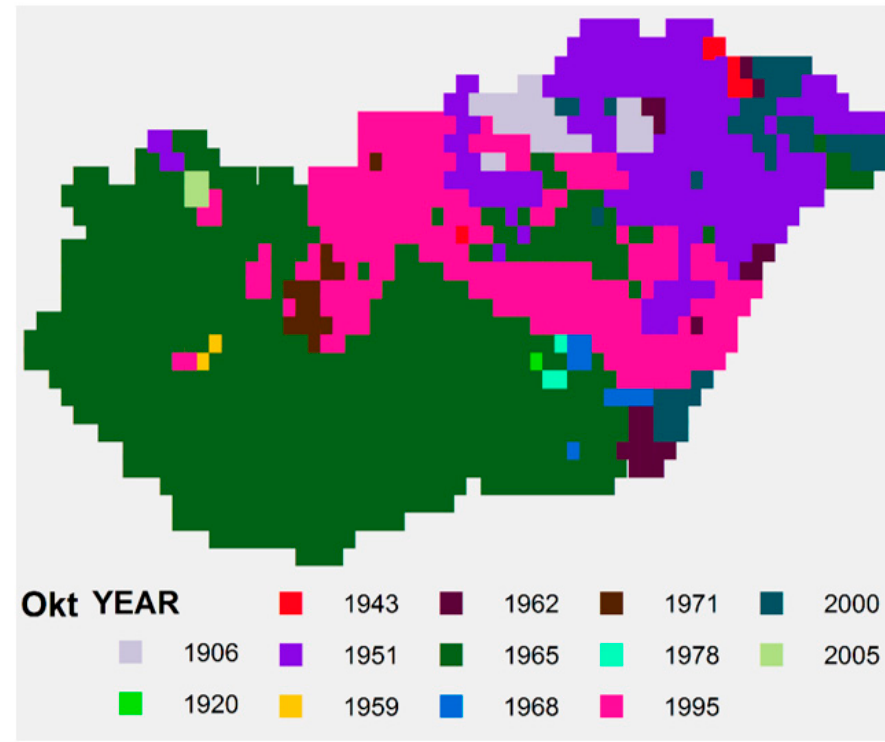
Figure A17. October: Year of maximum SPTI values, 1871–2020.